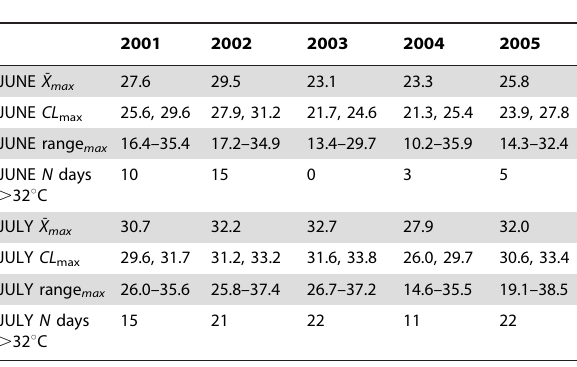
Table 4. Summary statistics for ambient temperatures ( o C) during June and July 2001–2005, Fort Collins, Colorado: means of daily maximum temperatures ( X¯ max ) and their lower and upper 95% confidence limits ( CL max ), the range of daily maxima (range max), and the number of days each month with temperatures exceeding 32 u C ( N days . 32 u C).